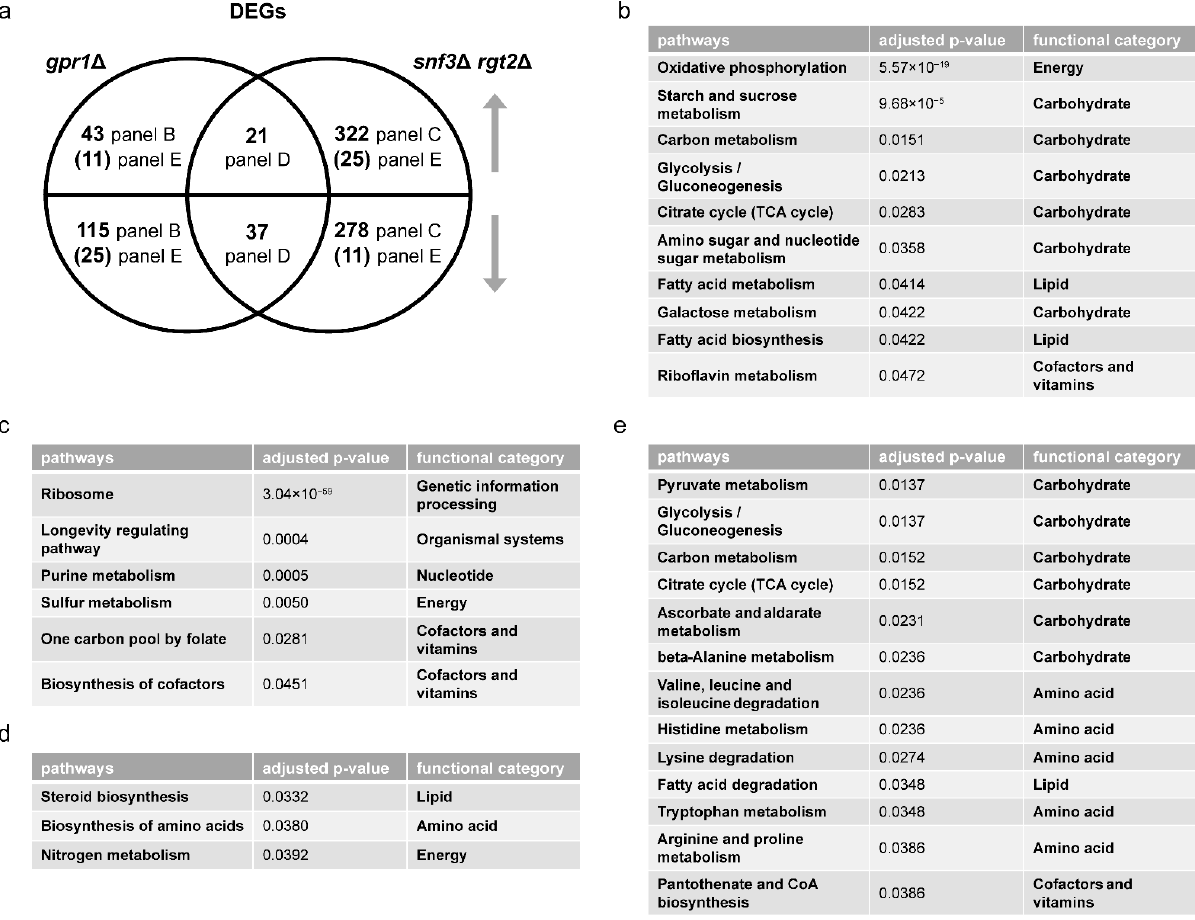
Figure 2. Comparing differentially expressed genes (DEGs) of gpr1 ∆ and snf3 ∆ rgt2 ∆ . ( a ) Venn diagram of subsets of DEGs, for gpr1 ∆ vs. wildtype and snf3 ∆ rgt2 ∆ vs. wildtype, after glucose addition to 2%. Upper semicircle shows up-regulated DEGs and lower semicircle shows down-regulated DEGs. Numbers in the overlapping region are shared DEGs regulated in the same direction. Numbers in parenthesis are shared DEGs regulated in the opposite direction, and are placed in the area corresponding to the direction of regulation. DEGs used for ORA analysis that are ( b ) unique to gpr1 ∆ ; ( c ) unique to snf3 ∆ rgt2 ∆ ; ( d ) shared and change in the same direction; ( e ) shared and change in the opposite direction. Listed are all pathways and their functional categories with adjusted p -value <